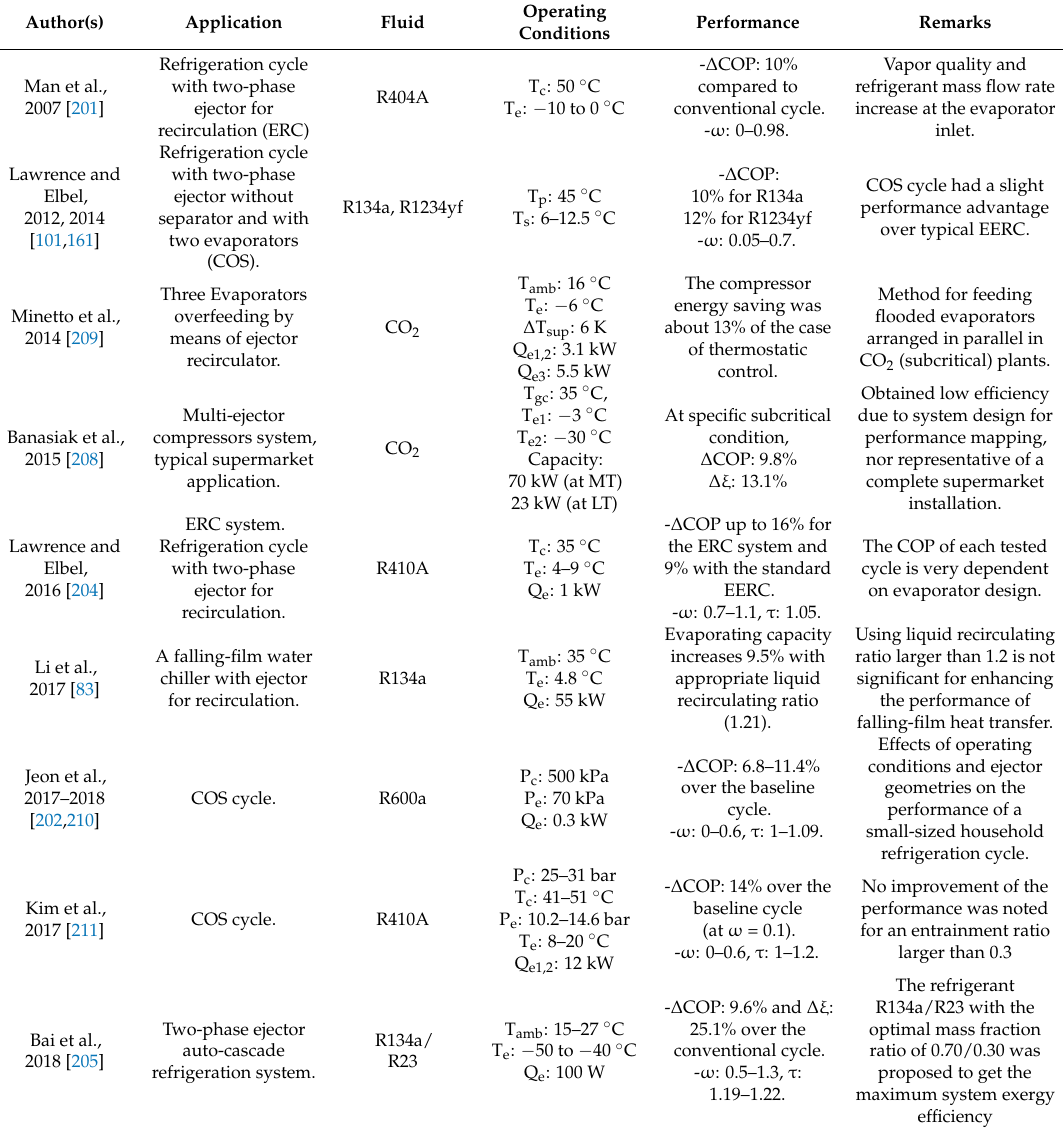
Table 9. Miscellaneous two-phase ejector applications (experimental